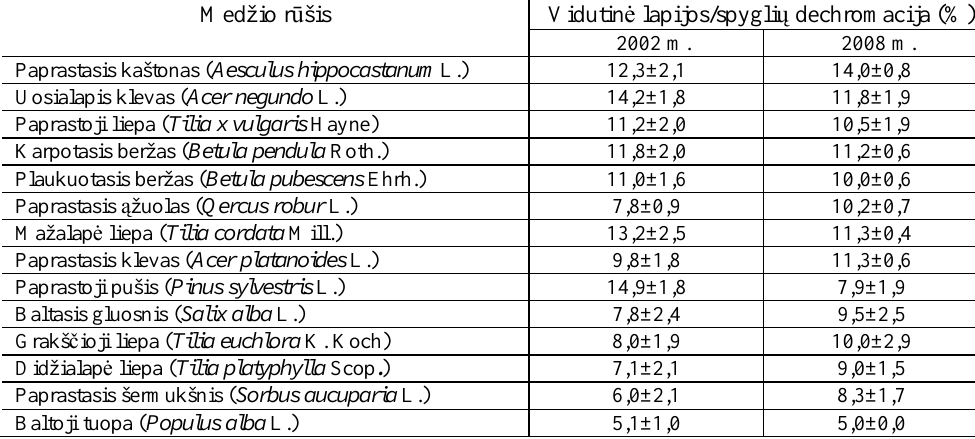
Table 1. Average crown defoliation values of different sampled tree species in 2002 and 2008 Vidutin ė lajos defoliacija (%) Medžio r ū šis 2002 m. 2008 m. Mažalap ė liepa ( Tilia cordata Mill.) 32,7±2,8 29,3±3,9 Paprastasis kaštonas ( Aesculus hippocastanum L.) 31,4±2,4 45,3±2,5 Uosialapis klevas ( Acer negundo L.) 30,9±2,3 28,2±3,1 Paprastasis ą žuolas ( Qercus robur L.) 27,8±2,2 22,3±3,5 Paprastoji liepa ( Tilia x vulgaris Hayne) 21,4±2,1 20,2±2,7 Karpotasis beržas ( Betula pendula Roth.) 22,9±1,8 20,9±1,1 Plaukuotasis beržas ( Betula pubescens Ehrh.) 18,2±3,2 17,1±2,2 Paprastasis klevas ( Acer platanoides L.) 25,6±1,5 24,1±2,6 Paprastoji pušis ( Pinus sylvestris L.) 30,6±2,1 24,7±3,7 Grakš č ioji liepa ( Tilia euchlora K. Koch) 25,7±2,8 25,2±3,1 Baltasis gluosnis ( Salix alba L.) 27,1±3 24,5±7,5 Baltoji tuopa ( Populus alba L.) 22,8±2,8 19,9±3,9 Didžialap ė liepa ( Tilia platyphylla Scop . ) 15,3±0,5 14,0±3,8 Paprastasis šermukšnis ( Sorbus aucuparia L.) 13,9±3,1 13,7±4,4